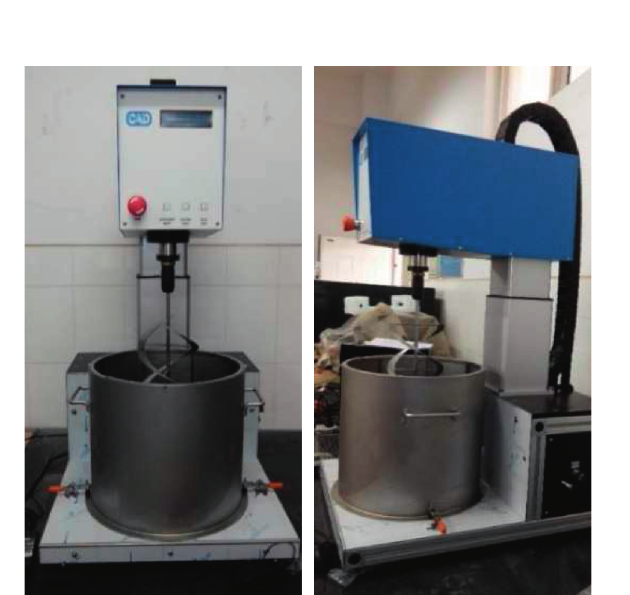
Figure 6: RheoCAD500 rheometer.